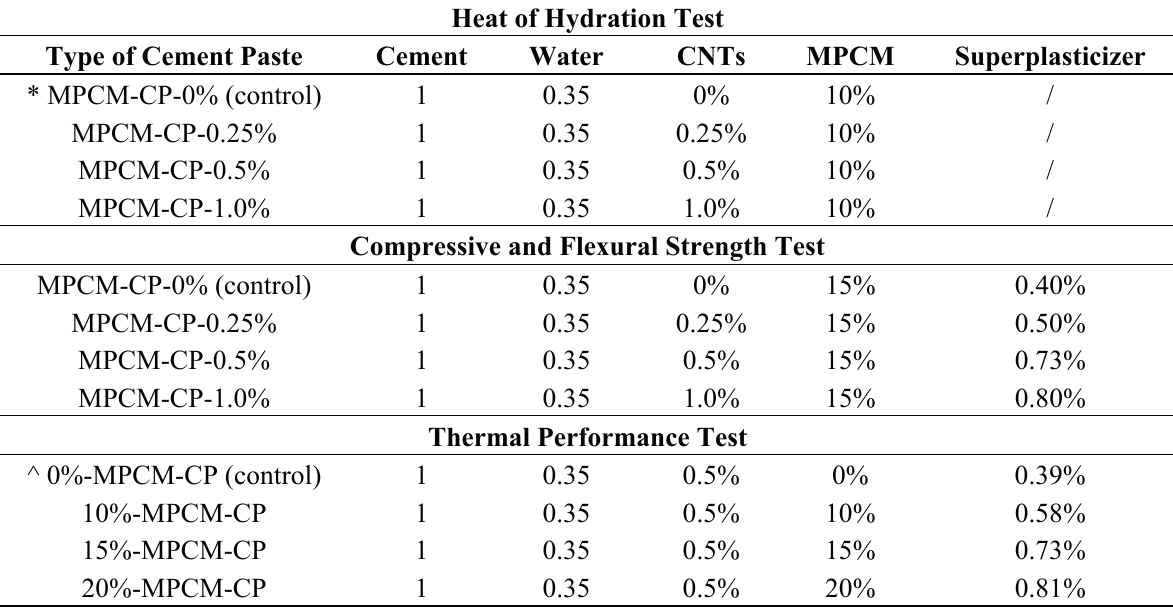
Table 3. Details of mix